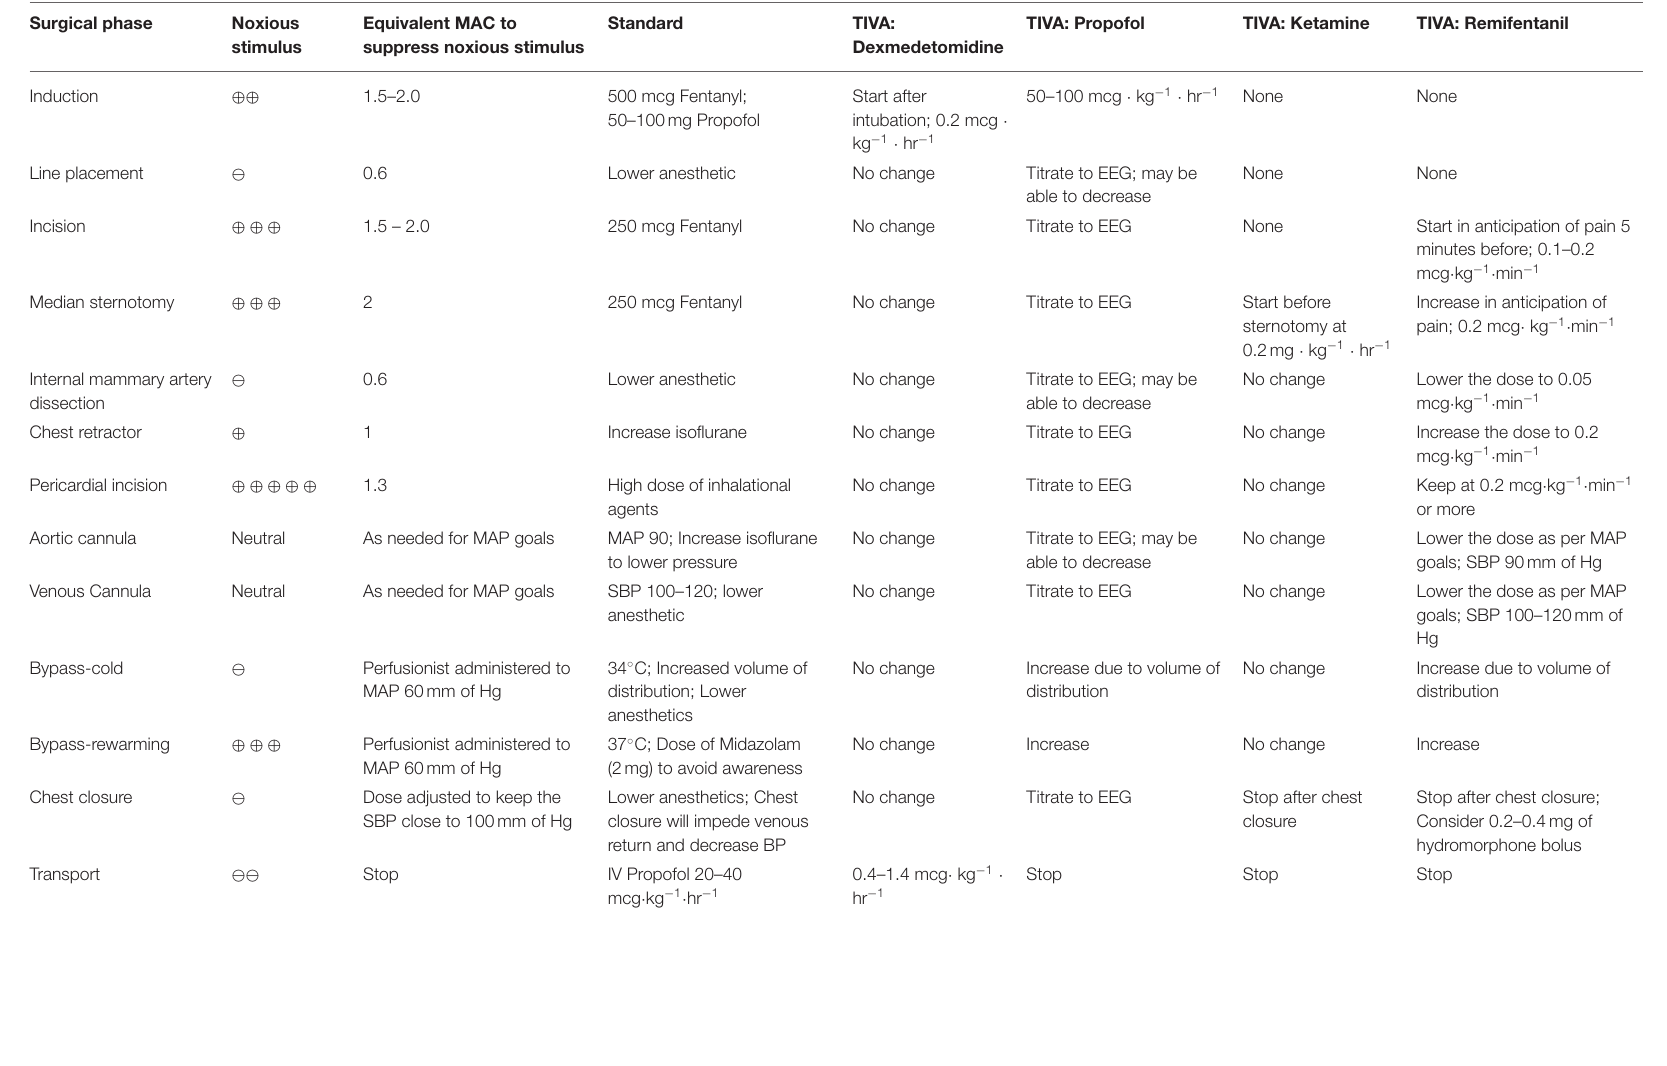
TABLE 1 | Approach for MMGA used in this study. Surgical